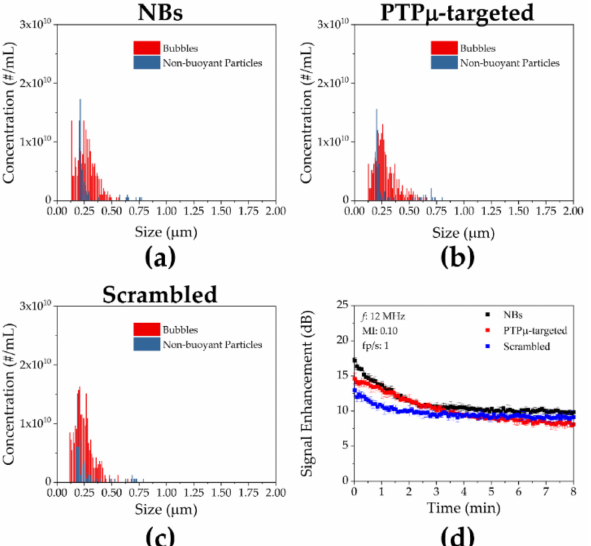
Figure 1. In vitro characterization of nanobubbles. The size and concentration distributions for ( a ) non-peptide modified nanobubbles (NBs), ( b ) Receptor Protein Tyrosine Phosphatase mu (PTP µ )- targeted NBs and ( c ) Scrambled NBs measured using Archimedes resonant mass measurement are shown. ( d ) In vitro ultrasound characterization of the three different NB types. No significant differences were seen between the